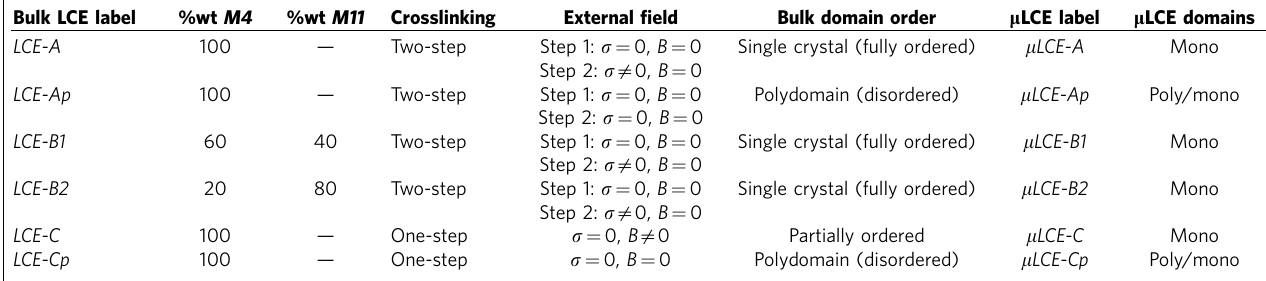
Shown are bulk LCE composition and fabrication parameters including the type of mesogens, crosslinking approach, external mechanical and magnetic field during crosslinking, and domain order of bulk materials, as well as domain character of their m LCE descendants.